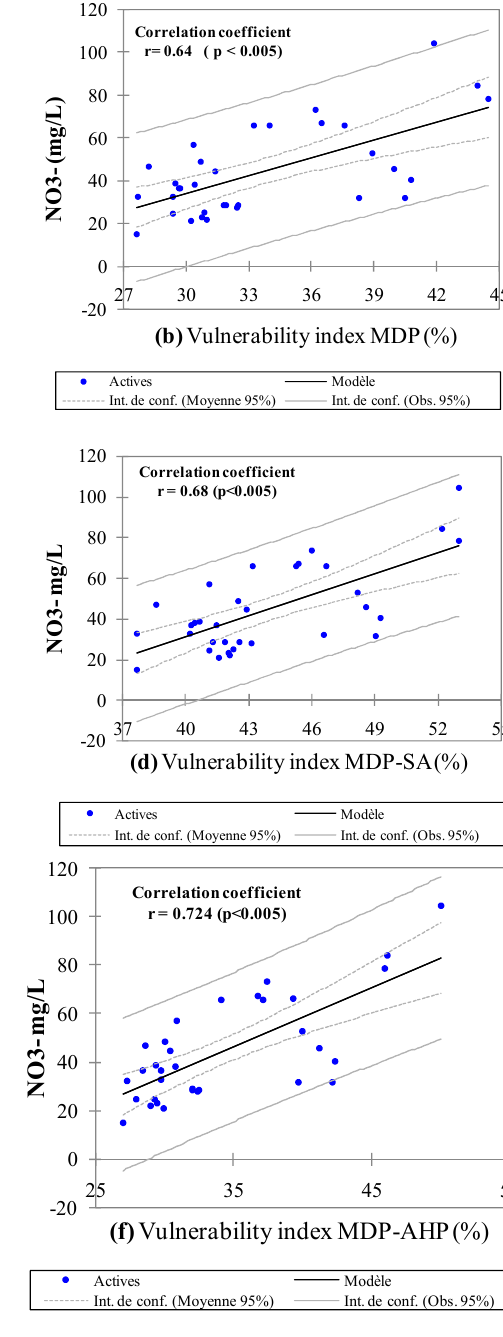
Figure 11. Correlation between vulnerability indexes and nitrate concentration; ( a ) MDC–NO 3 − ; ( b ) MDP–NO 3 − ; ( c ) MDC–SPSA–NO 3 − ; ( d ) MDP–SPSA–NO 3 − ; ( e ) MDC–AHP–NO 3 − and ( f ) MDP–AHP– NO 3 − .